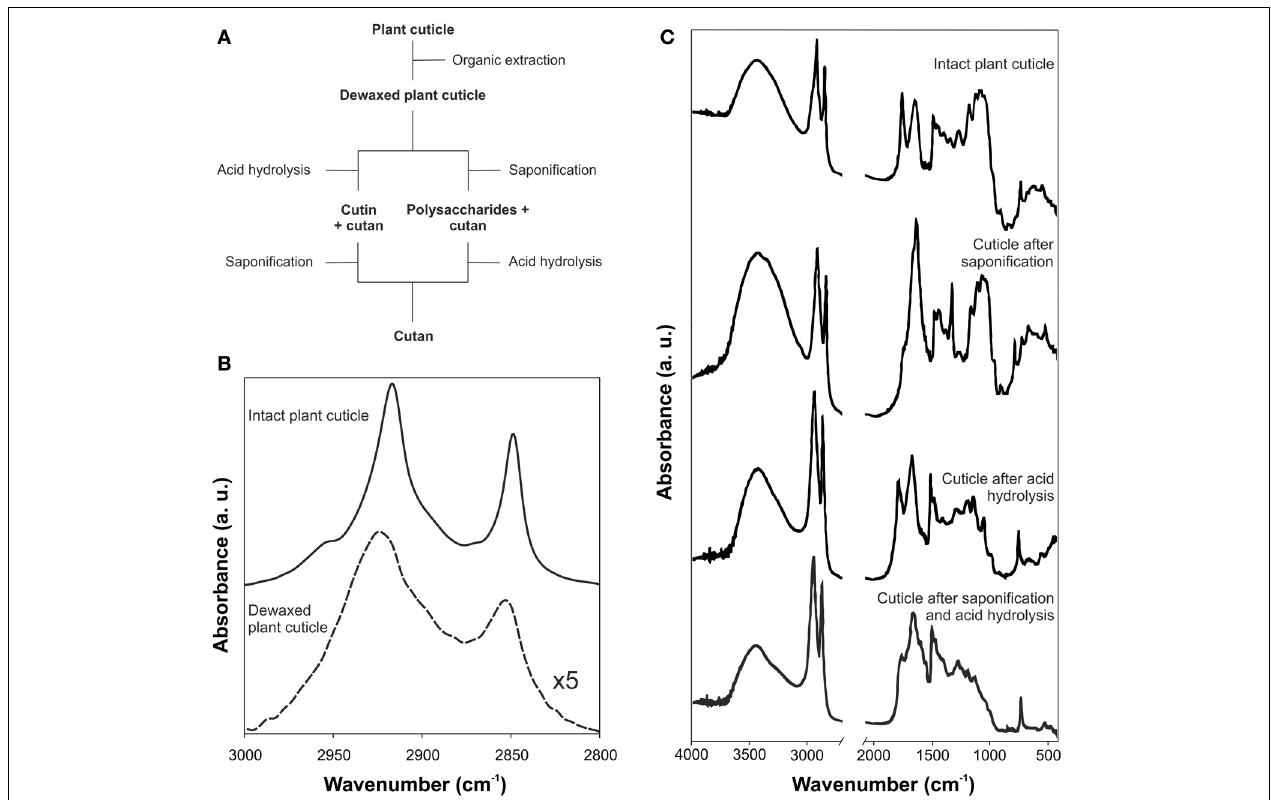
FIGURE 3 | (A) Scheme for the sequential removing of cuticular components. (B) ATR-FTIR spectra of intact and dewaxed plant cuticle of peach fruit (adapted from Fernández et al., 2011, www.plantphysiology.com, Copyright